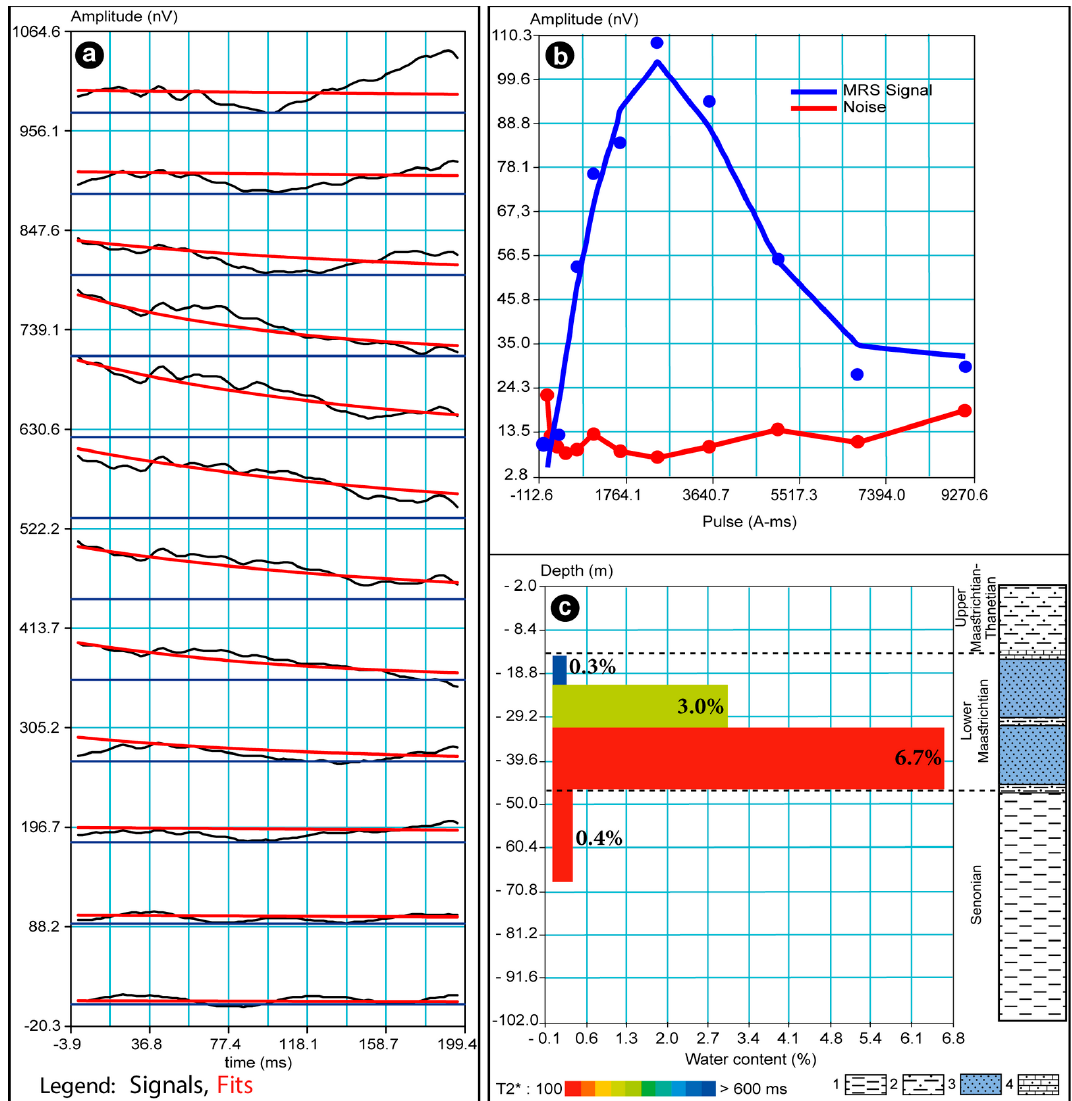
Figure 5. ( a ) Magnetic resonance sounding (MRS) signal relaxation curves versus time for the various pulse moments injected; ( b ) amplitude of measured MRS signal and noise level; ( c ) model resulting from MRS data inversion and its correlation with hydrogeological column; 1: Marl; 2: Phosphatic marl; 3: Uncemented phosphate; 4: Phosphatic limestones.